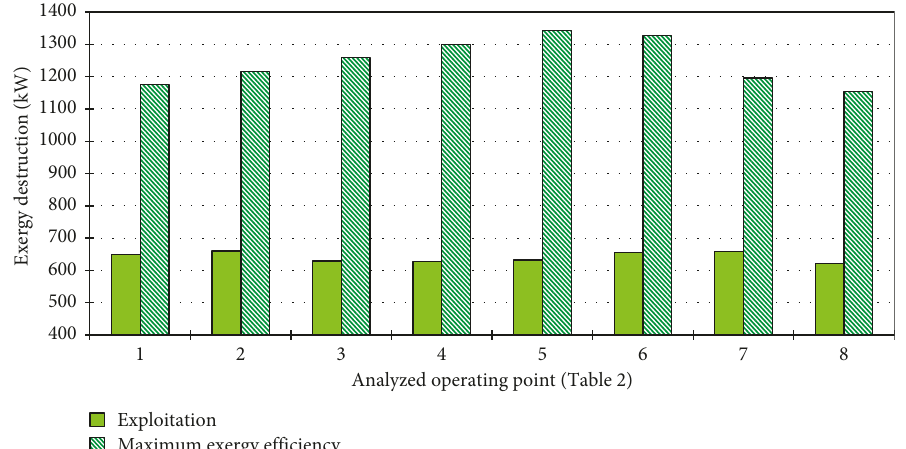
Figure 13: Comparison of exergy destructions for all analyzed operating points—exploitation versus maximum exergy efficiency